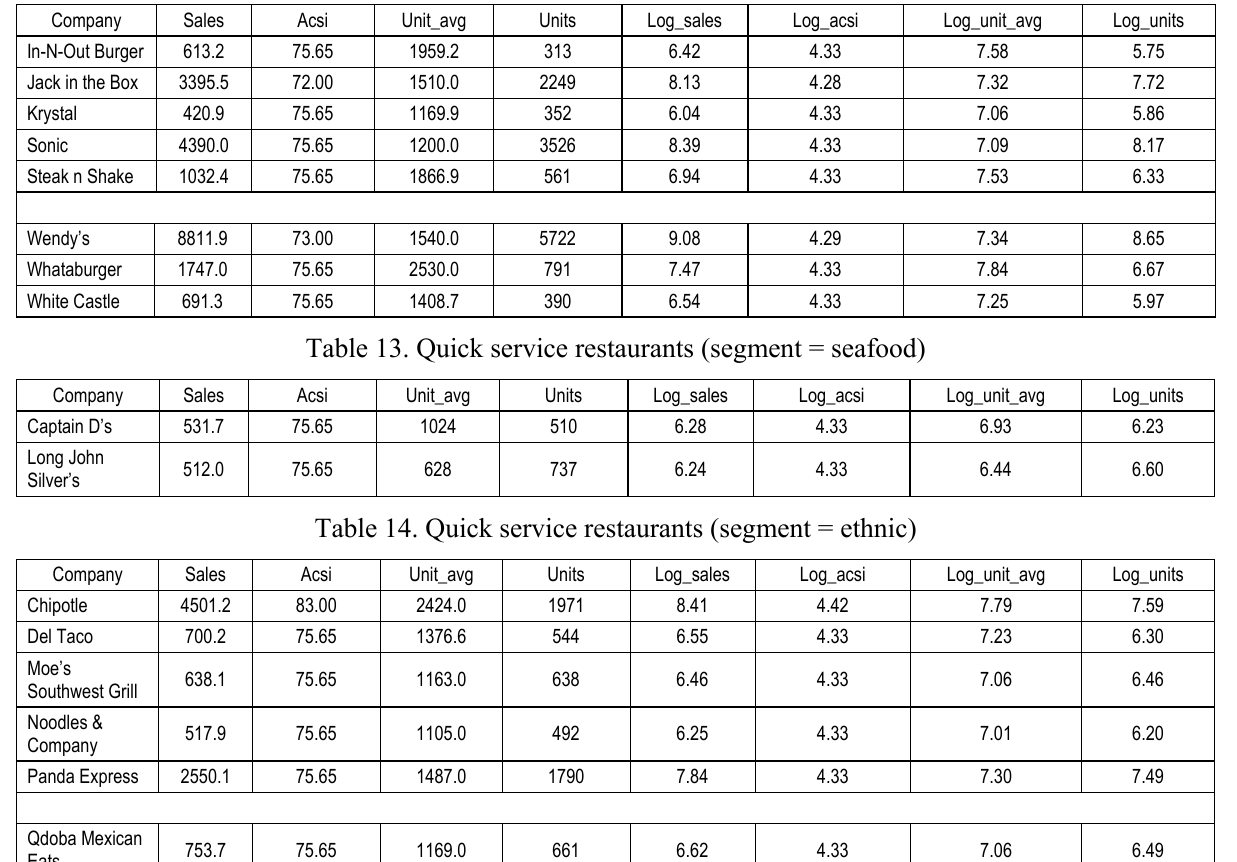
Table 12. (cont.) Quick service restaurants (segment = burger)